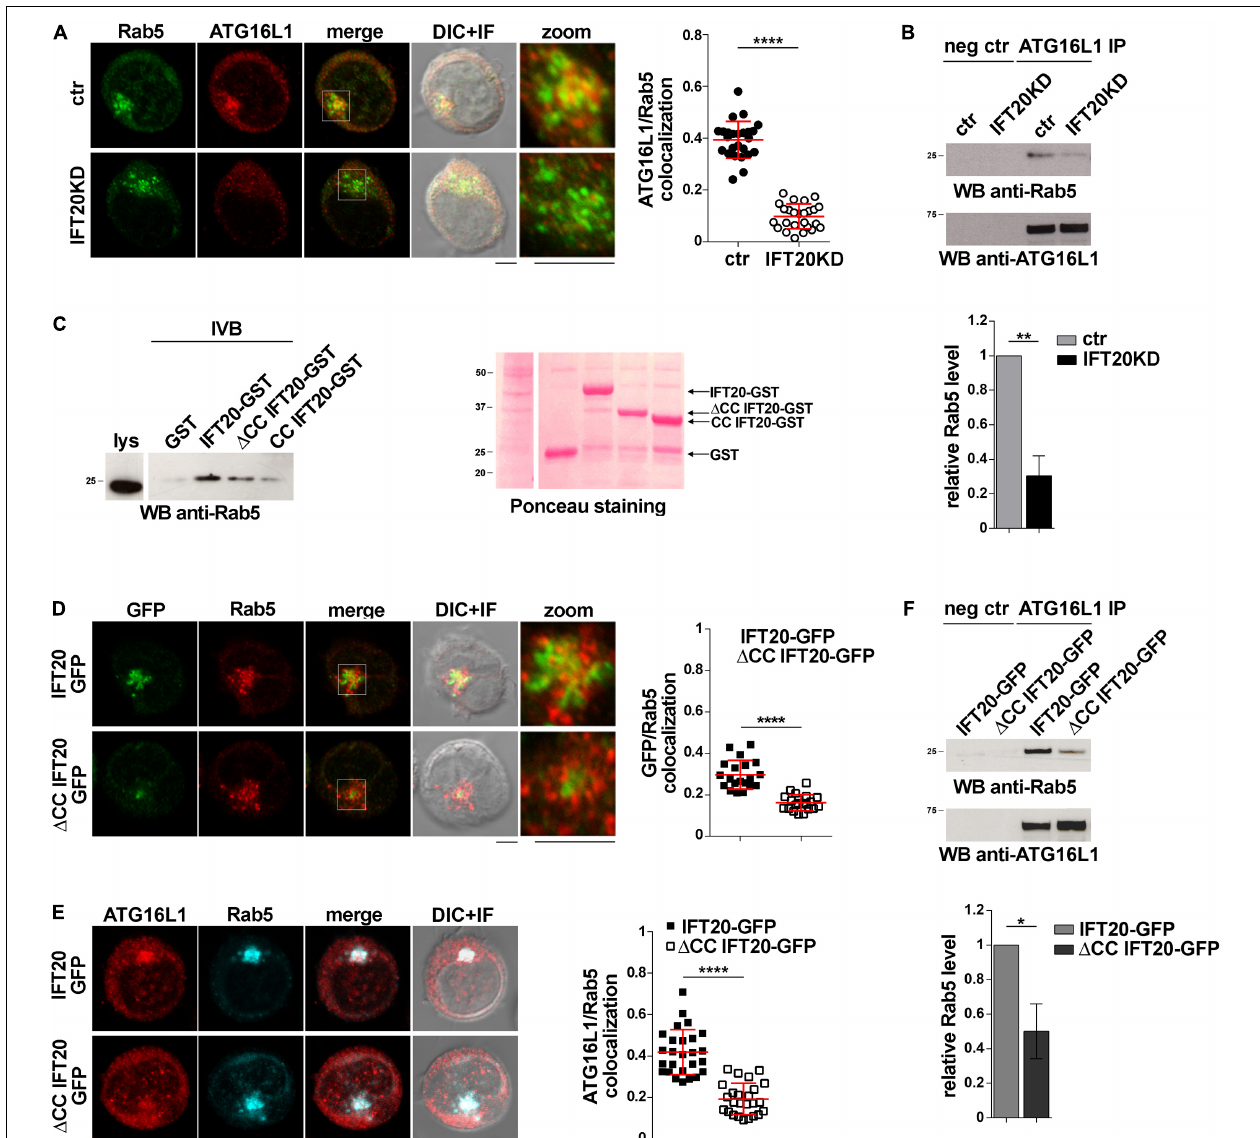
FIGURE 4 | IFT20 couples ATG16L1 to early endosomes through interaction with Rab5. (A) Immunofluorescence analysis of ATG16L1 and Rab5 GFP in control and IFT20KD Jurkat cells. Representative medial optical sections and overlay of immunofluorescence and DIC images are shown (IF + DIC). Scale bar: 5 µ m. The graph shows the quantification of the weighted colocalization (Mander’s coefficient) of ATG16L1 and the early endosome marker Rab5 in ctr and IFT20KD Jurkat cells (= 25 cells/sample, n = 3; mean ± SD; Student’s t -test). (B) Immunoblot analysis with anti-Rab5 antibodies of ATG16L1-specific immunoprecipitates from lysates of control and IFT20KD Jurkat cells. Preclearing controls are included in each blot (neg ctr). Tested proteins show comparable expression in total cell lysate from ctr and IFT20KD Jurkat cells ( Supplementary Figures 3A,B ). The migration of molecular mass markers is indicated. The quantification of the relative protein expression normalized to ATG16L1 (mean fold ± SD; ctr value = 1) is reported for each blot ( n = 3; mean ± SD; Student’s t -test). (C) Immunoblot analysis with anti-Rab5 antibodies of in vitro -binding assays carried out on post-nuclear supernatants of Jurkat cells using IFT20-GST, (cid:49) CC IFT20-GST, and CC IFT20-GST fusion proteins, or GST as negative control. The Ponceau red staining of the same filter is shown to compare the levels of fusion proteins and GST used in the assay. The immunoblot shown is representative of three independent experiments. (D) Immunofluorescence analysis of GFP and Rab5 in Jurkat cells expressing IFT20-GFP and (cid:49) CC IFT20-GFP. The graph shows the quantification using Mander’s coefficient of the weighted colocalization of GFP and Rab5 in Jurkat transfectants reported as mean value/cell calculated on individual Rab5 + dot (= 20 cells/sample, n = 3; mean ± SD; Student’s t -test). (E) Immunofluorescence analysis of ATG16L1 and Rab5 in IFT20-GFP and (cid:49) CC IFT20-GFP Jurkat transfectants. The graph shows the quantification of the weighted colocalization (Mander’s coefficient) of ATG16L1 and Rab5 ( ≥ 25 cells/sample, n = 3; mean ± SD; Student’s t -test) in Jurkat transfectants. Representative medial optical sections and overlay of immunofluorescence and DIC images are shown (IF + DIC). Scale bar: 5 µ m. (F) Immunoblot analysis with anti-Rab5 antibodies of ATG16L1-specific immunoprecipitates from lysates of Jurkat cells expressing IFT20-GFP or (cid:49) CC IFT20-GFP. Preclearing controls are included in each blot (neg ctr). The migration of molecular mass markers is indicated. The quantification of Rab5 levels normalized to ATG16L1 (mean fold ± SD; ctr value = 1) is shown ( n = 3; mean ± SD; Student’s t -test). ** P < 0.01; *** P < 0.001; **** P < 0.0001.